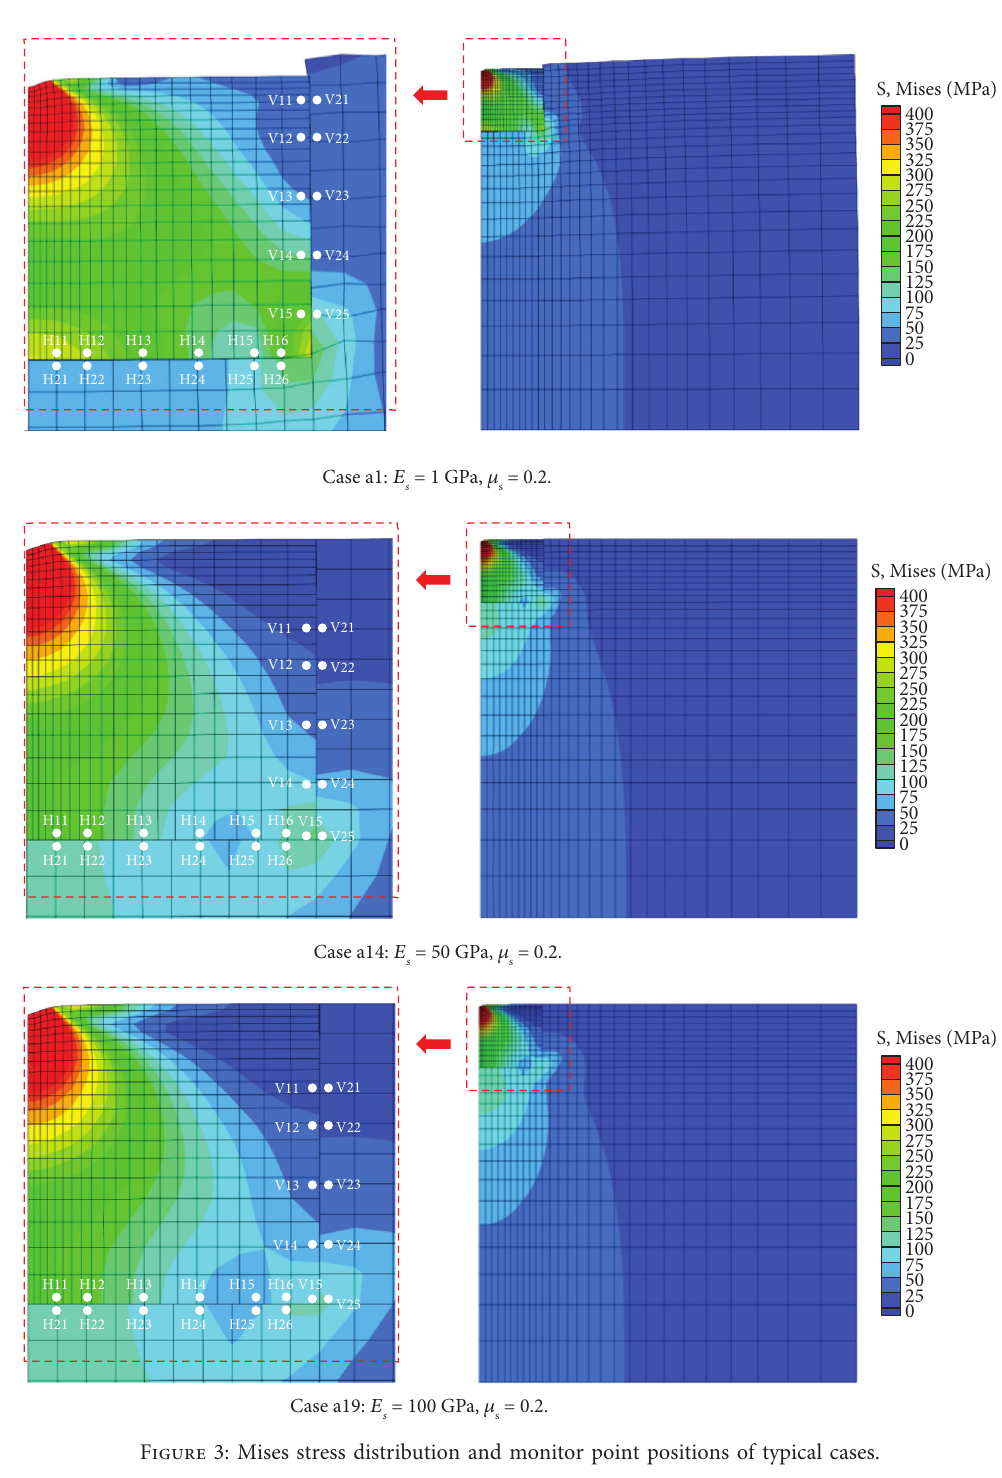
Figure 3: Mises stress distribution and monitor point positions of typical